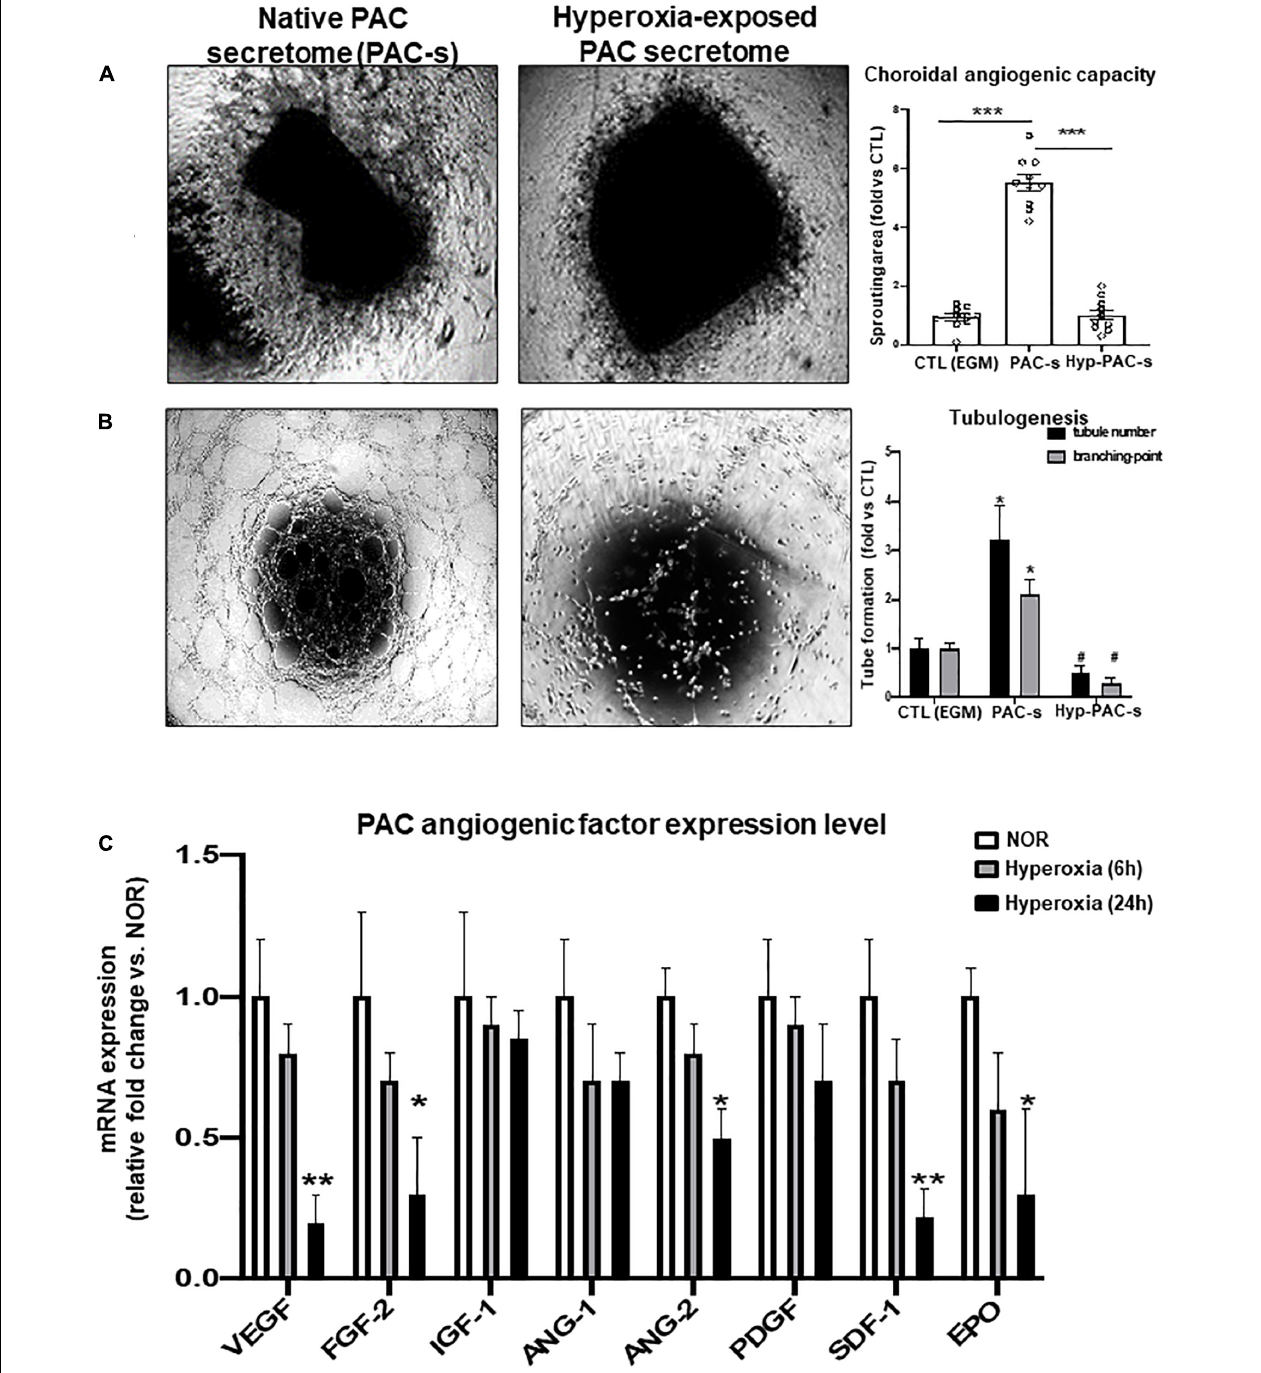
FIGURE 2 | PACs exposed to hyperoxia display reduced paracrine angiogenic activity. (A,B) To explore the potential deleterious effect of hyperoxia (80% O 2 ) on PAC activity, PACs were exposed for 24 h to hyperoxia (hyp-PAC-s) or normoxia (PAC-s) before harvesting the supernatant (conditioned media). Endothelial growth medium (EGM) was used as a positive control. (A,B) Microscopic images and quantification of tubule sprouting in choroid explants after 5 days in culture (A) and in HMRECs after 6 h of treatment with the different culture media (B) . (C) qRT-PCR analyses of angiogenic factor expression in PACs exposed to hyperoxia for 6 and 24 h compared to PAC in normoxic conditions (NOR). Data are mean ± SEM. * P < 0.05 or ** P < 0.01 or *** P < 0.001 vs. control (EGM or NOR) or # P < 0.05 vs. PAC-s. N = 3–4 experiments (B,C) or N = 10 choroid explant (A)